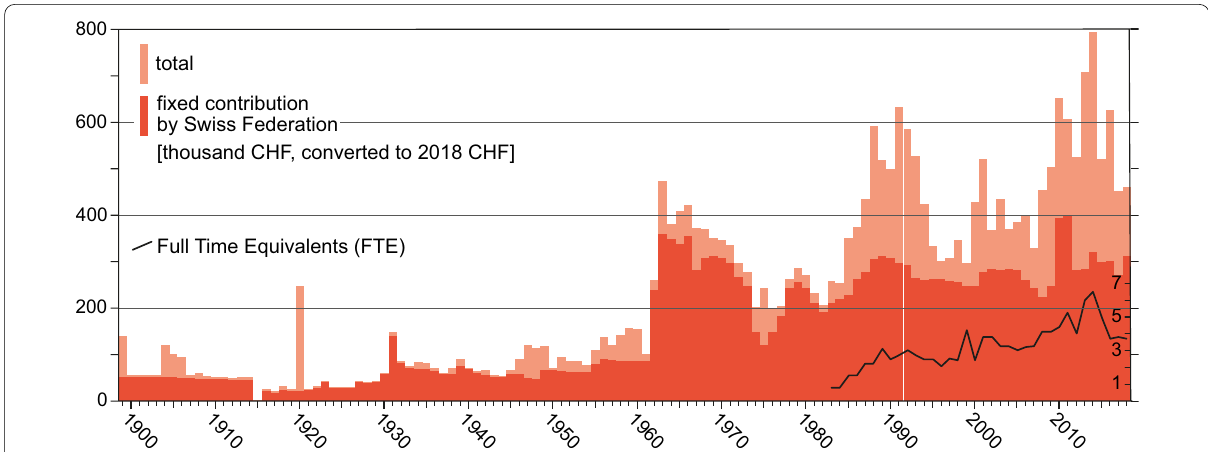
Fig. 15 Annual SGTK funding, split into the fix annual contribution from the Federation (dark red) and project-based contributions from various sponsors. Values are adjusted for inflation according to the Swiss Consumer Price Index by the Federal Statistical Office (BFS). Data between 1899 and 1974 are from SNG annual reports (SNG 1900–1974), data between 1975 and 2018 are from unpublished SGTK annual reports. The fixed contribution contains funding from SNG/SCNAT (funding since 1899), from different federal offices (since 1970) and from ETH Zurich (since 2002). The SNG/SCNAT share was 100% from 1899 to 1969 and declined to 4–10% after 1970. The share of the federal offices ranged between 75 and 97% of the total fixed contribution. Since the early 1960s, the fixed contribution by the federation (incl. SCNAT & ETH Zurich) was in the order of 220 to 350 kCHF. The non-fixed contribution during that period ranged between ca. 25 and 400 kCHF with an average of about 95 kCHF in the 1960–1990s and ca. 205 kCHF after 1999. A substantial part (up to about half) of the non-fixed contribution came also from the federation, mainly for the production of the different sheets of the Hydrogeological Maps ( Hydrogeologische Karte der Schweiz 1:100 ′ 000 ). The rest of the funding was raised through applied research projects for industry. Full time equivalents (FTE) are only given for the time after 1983, as SGTK was only able to finance own staff since